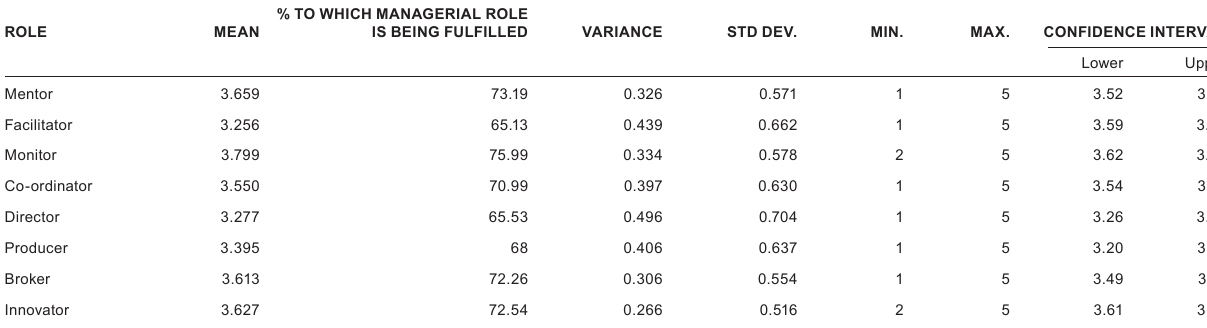
Table 4 Descriptive statistics: Managerial roles needed to create master